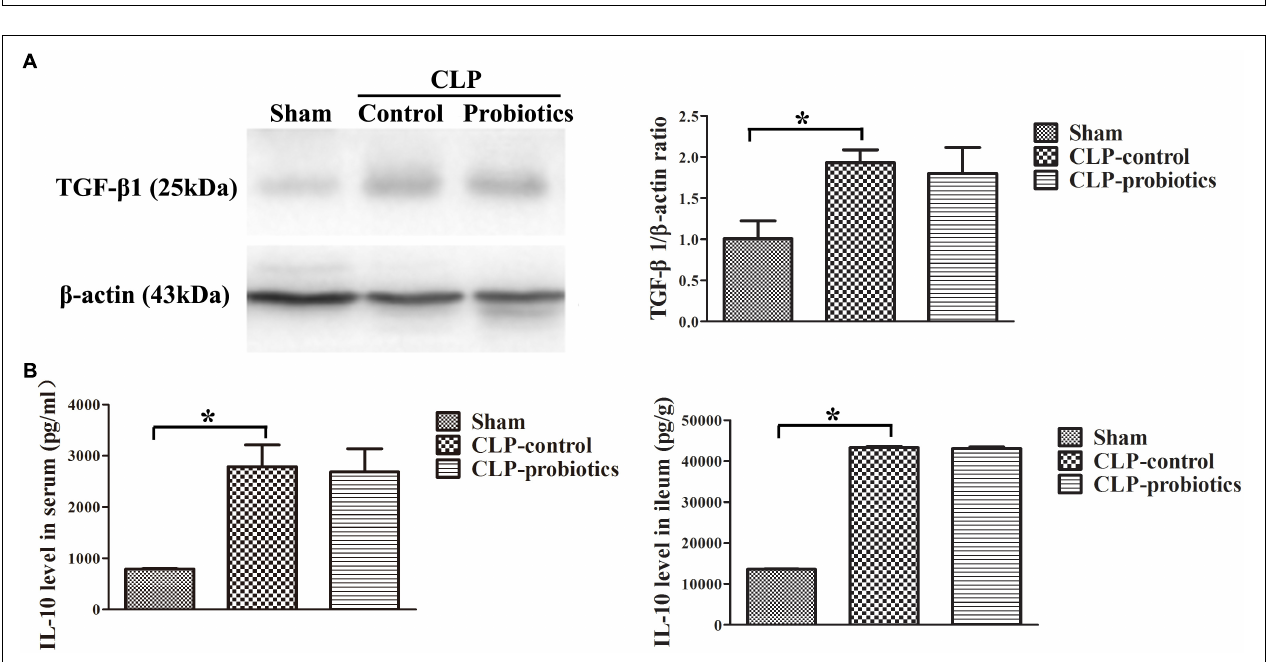
FIGURE 3 | The levels of pro-inflammatory IL-6 and TNF- α in the septic mice with or without LCBE treatment. (A) IL-6 level in serum and ileal tissues were examined by ELISA. LCBE enteric-coated capsules decreased the expression of IL-6. (B) TNF- α level in serum and ileal tissues were examined by ELISA. LCBE enteric-coated capsule treatment decreased the expression of TNF- α . All data were presented as means ± SEM. N = 6 mice/group; ∗ P < 0.05.